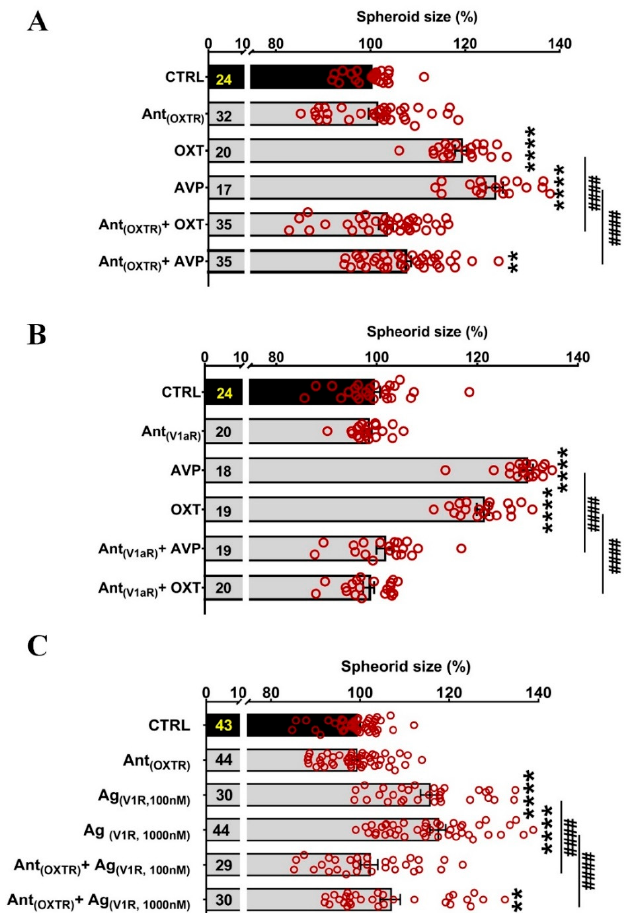
Figure 5. Effects of the Ant (OXTR) and Ant (V1R) on the inhibition of OXT/AVP-induced neurospheroid size changes. ( A ) OXT and AVP both increase spheroid size significantly. The Ant (OXTR) blocks the OXT- and AVP-induced increase. One-way ANOVA (F (5,156) = 39.18, p = 0.0001), Holm–Sidak ** p = 0.005, **** p < 0.0001 compared to CTRL; #### p < 0.0001 compared to the indicated group. ( B ) Similar to the Ant (OXTR) , the Ant (V1R) blocks the OXT- and AVP-induced increase in spheroid size. One-way ANOVA (F (5,113) = 124.5, p < 0.0001); Holm–Sidak **** p = 0.0001 compared to CTRL; #### p = 0.0001 compared to the indicated group. ( C ) The Ag (V1R) increases spheroid size to a similar extent as OXT and AVP, however, the effect is blocked by the Ant (OXTR) . One-way ANOVA (F (5,214) = 28.16, p < 0.0001), Holm–Sidak ** p = 0.005, **** p = 0.0001 compared to CTRL; #### p = 0.0001 compared to the indicated